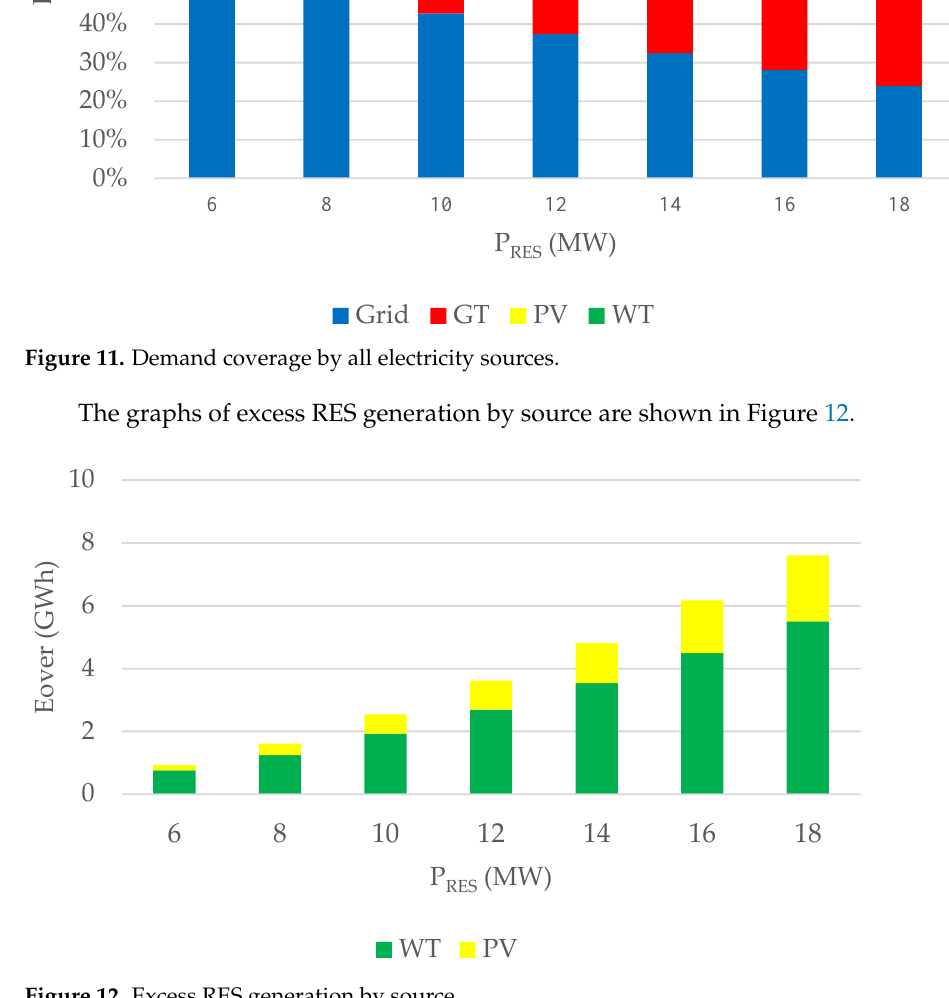
Figure 12. Excess RES generation by source.